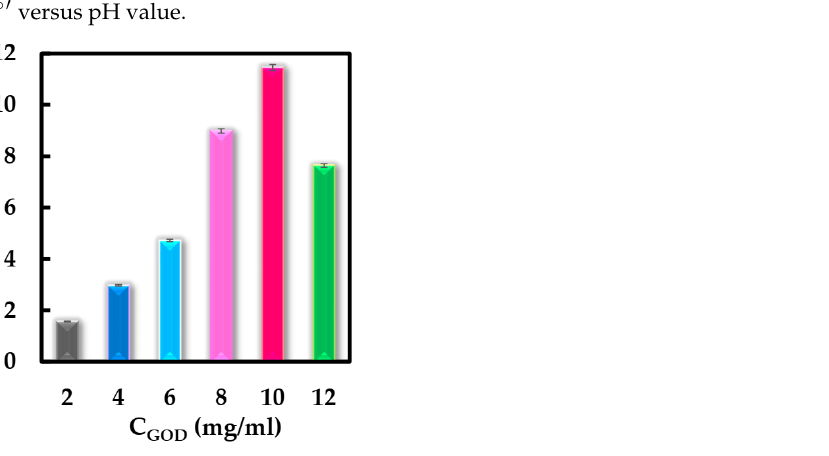
Figure 7. Peak cathodic current obtained from NF-GLA/MWCNTs-BSA-HFs-GOD/GCE with different concentrations of GOD in N 2 -saturated 50 mM phosphate-buffered solution (pH 6) at a scan rate of 0.05 V ‧ s −1 .